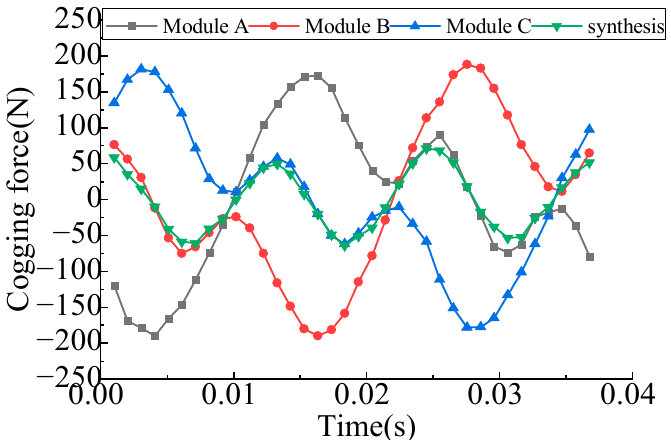
Figure 4. Modular principle verification diagram.